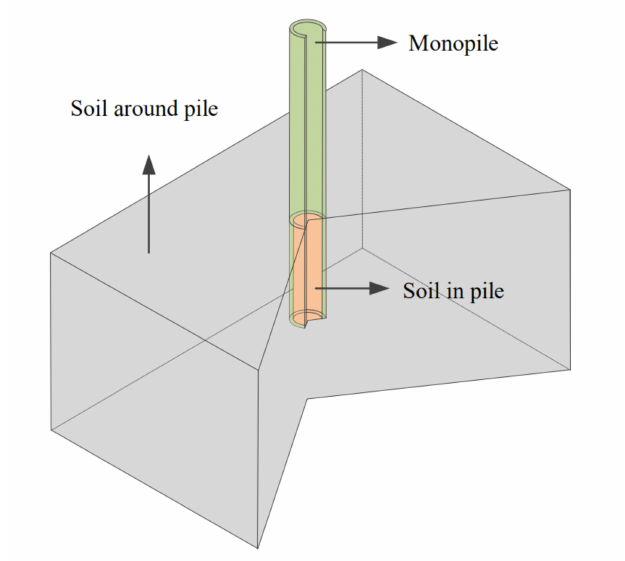
Figure 2. Basic monopile-soil